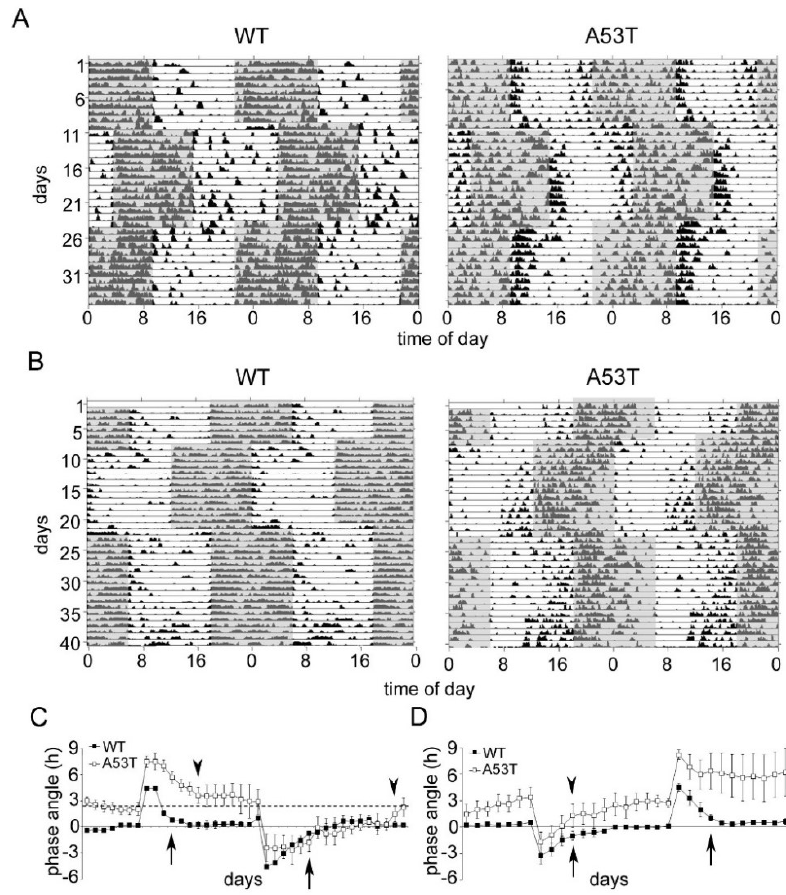
Figure 4. Re-entrainment of spontaneous locomotor activity rhythms in WT and A53T mice subjected to experimental jet lag. ( A ) Double-plotted actograms of locomotor activity from representative WT and A53T mice subjected to a 6 h phase delay followed by a 6 h phase advance back to the former photoschedule. Grey shading indicates periods of darkness; ( B ) Double-plotted actograms of locomotor activity from representative WT and A53T mice subjected to a 6 h phase advance followed by a 6 h phase delay back to the former photoschedule. Grey shading indicates periods of darkness; ( C ) Phase angle of locomotor activity in WT and A53T mice after the 6 h phase delay followed by the 6 h phase advance. The data are expressed as the mean ± SEM of four mice in each genotype. Arrow and arrowheads indicate the first day of re-entrainment to the new photoschedule in WT and A53T mice, respectively. Re-entrainment to a new photoschedule is defined by the difference between phase angle and basal phase angle <1.5 h. In WT mice, the basal phase angle is very close to the x -axis; in A53T mice, the basal phase angle is indicated by the dashed line; ( D ) Phase angle of locomotor activity in WT and A53T mice after the 6 h phase advance followed by the 6 h phase delay. The data are expressed as the mean ± SEM of four mice in each genotype. Arrow and arrowheads indicate the first day of re-entrainment to the new photoschedule in WT and A53T mice, respectively. Data are expressed as the mean ± SEM; n = 8 mice in each experimental group, n = 4 mice per genotype in each experimental group.